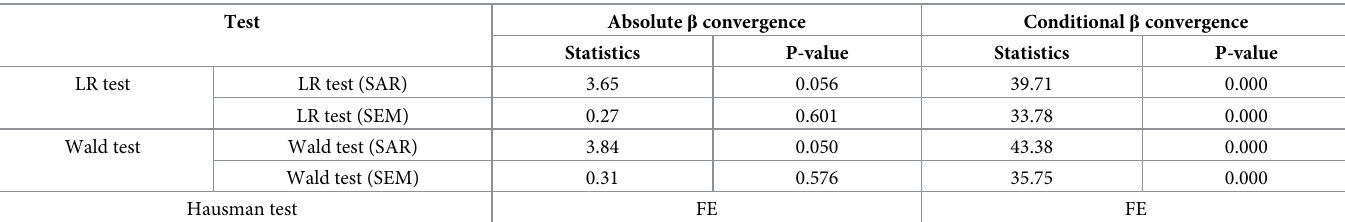
Table 5. Model applicability test.